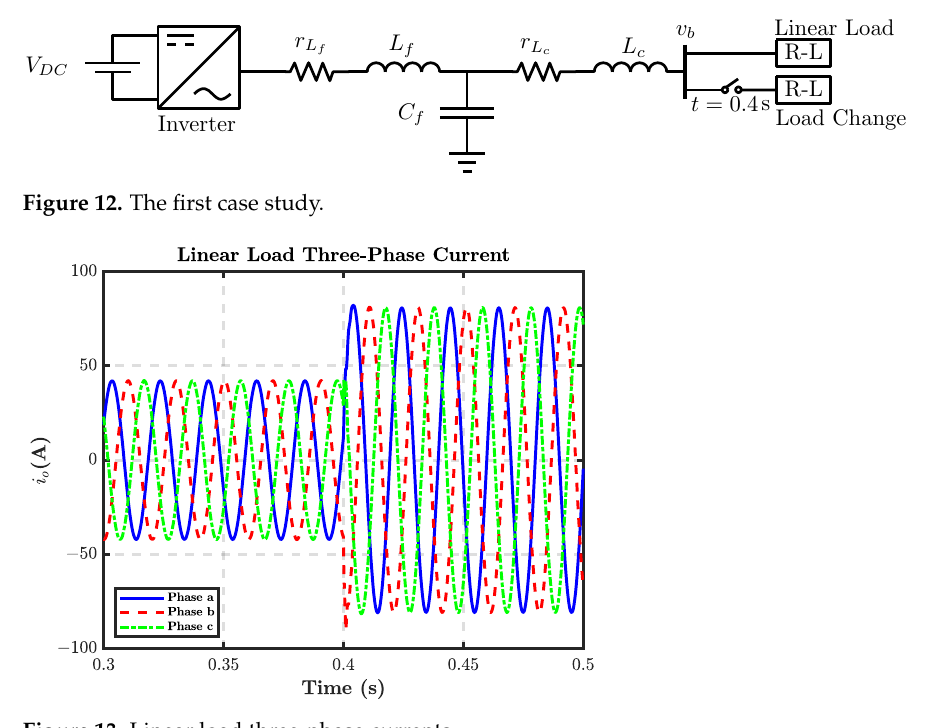
Figure 13. Linear load three-phase